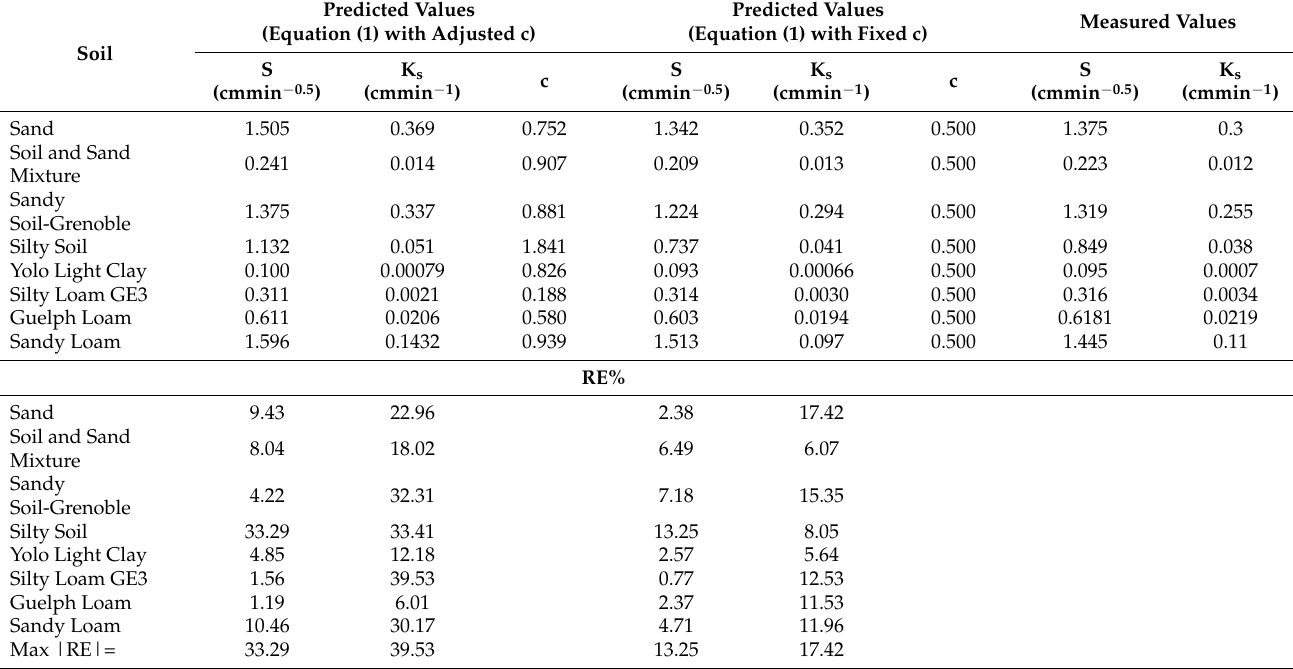
Table 3. Measured values of S and K s and predicted values of S, K s , and c from the Equation (1) using the Solver application considering (a) all the three parameters as adjustment parameters, and (b) the S and K s as adjustment parameters and the c = 0.500. Relative errors (RE%) of the predicted values of S and K s for all porous media